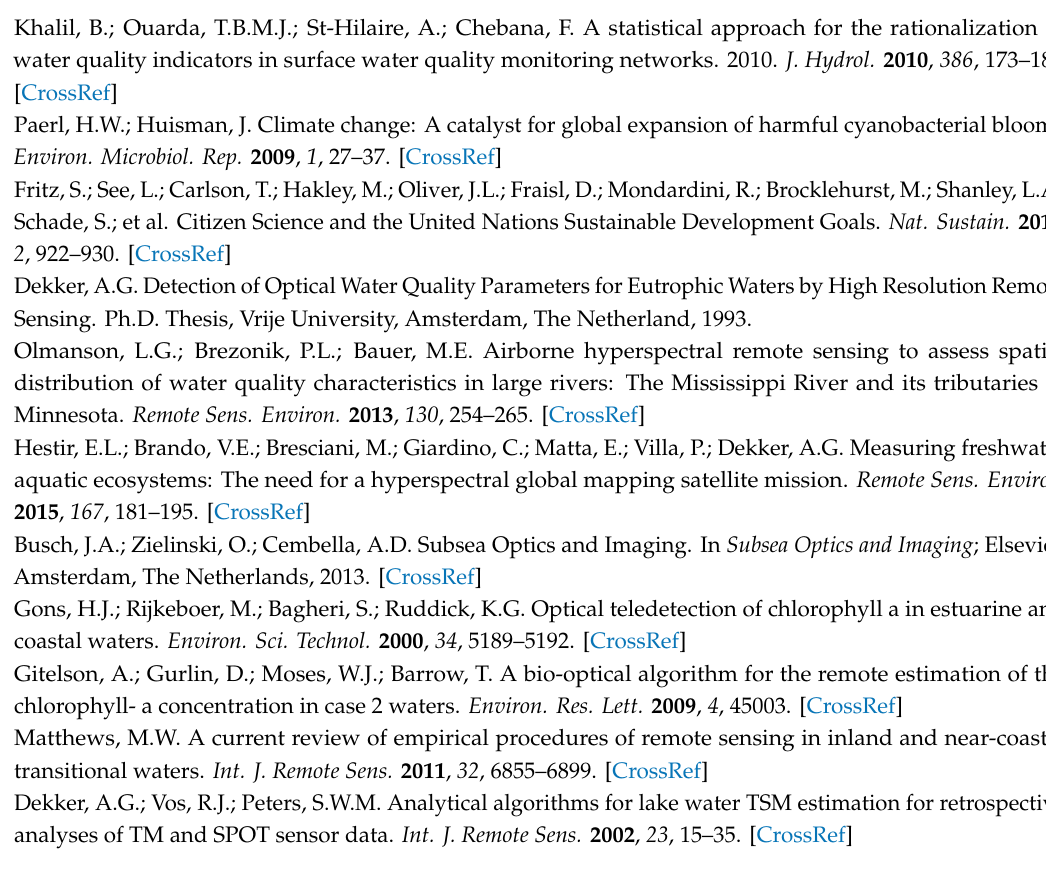
Figure S1: Mean raw spectra for panel and water surface measurements made at Station 6 on Lake Liddell, 02.03.2016, presented together with standard deviation and coe ffi cient of variation, Figure S2: Model outcomes to show changes in hue angle when a spectrometer is lowered to 5 cm depth in natural waters, Table S1: Summary of the basic measurements from all